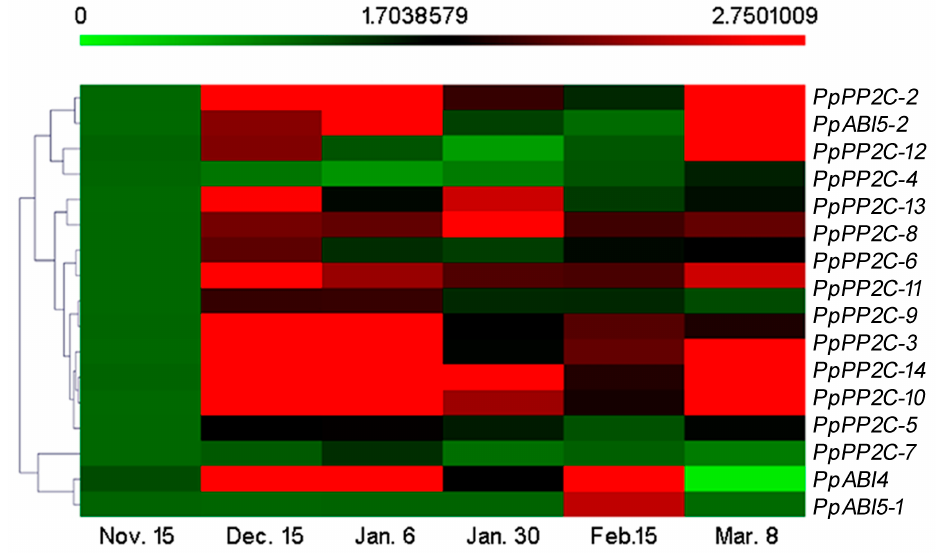
Figure 3. Relative gene expression levels of 17 PP2C s and ABI4 / 5 s genes during flower bud dormancy in 2011–2012. Expression values were normalized to the value of the PpACTIN gene. Each value represents the average of three biological replicates. The sampling dates were 15 November, 15